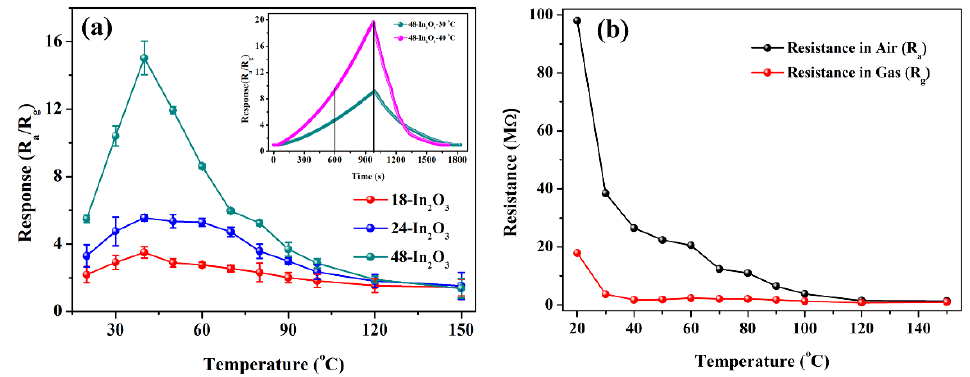
Figure 5. ( a ) Response of the porous In 2 O 3 samples relative to operating temperature to 500 ppm of CH 4 (the inset shows the response – recovery curve of 48-In 2 O 3 to 200 ppm methane at 30 and 40 °C, respectively.); ( b ) The change in resistance (R a and R g ) of the 48-In 2 O 3 sensor in air and gas with the sensor working temperature.